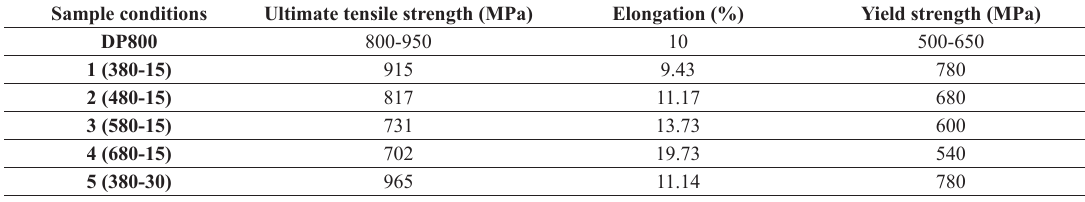
Table 2. Values of mechanical properties before and after treatments. Sample conditions